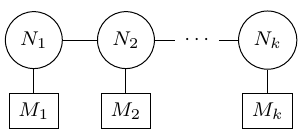
Figure 1 . Linear quiver with gauge group U( N 1 ) (cid:2) (cid:1) (cid:1) (cid:1) (cid:2) U( N k